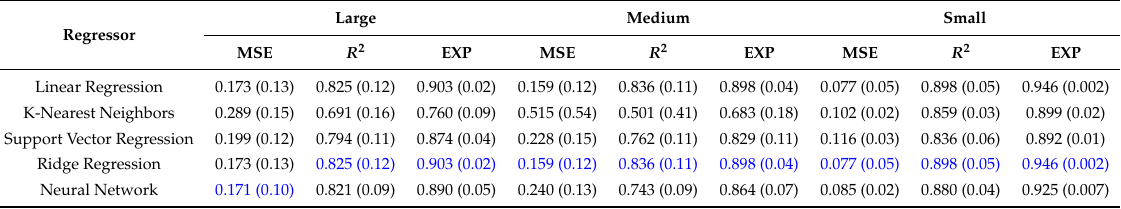
Table 3. Angle estimation using external forces with blue indicating best results.